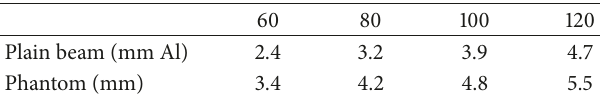
Table 2: Measured Half Value Layer (HVL) thicknesses of the phantom (in mm) at 60, 80, 100, and 120 kVp energy for the X-ray unit